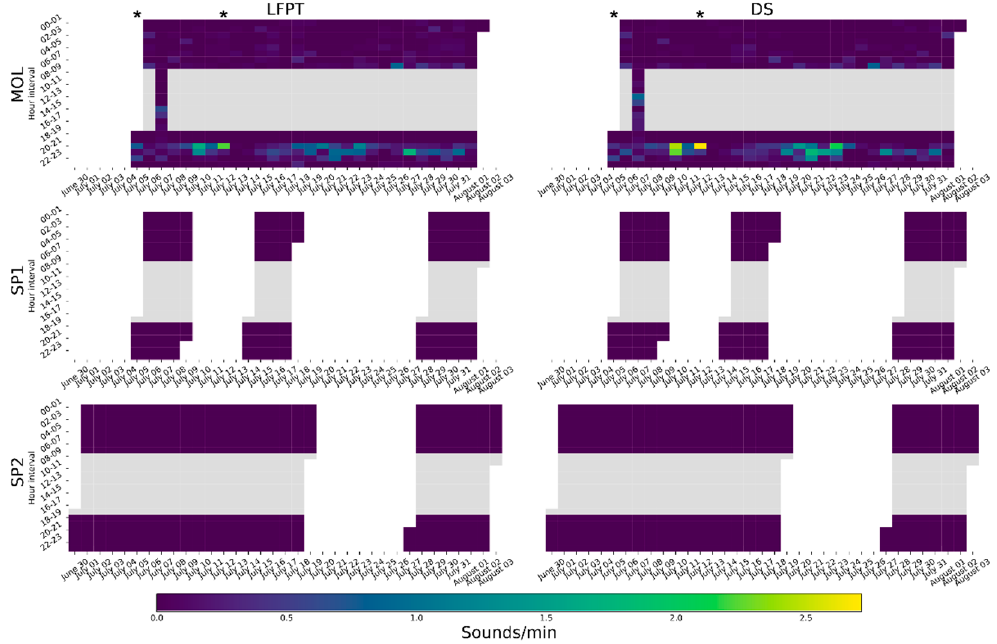
Figure 7. Weighted sound abundances (number of sounds by sound type (left: LFPT; right: DS) per effective minute of recording within an hour interval) recorded across the three sites throughout the month of July 2017 (hours refer to CEST). The asterisks (*) indicate the dates when presumptive courtship displays and also an aggregation (12 July) were observed. The white areas indicate absence of acoustic data, while grey areas indicate that recordings were not analysed. On 7 July, the recordings for the whole day (24 h) were analysed.